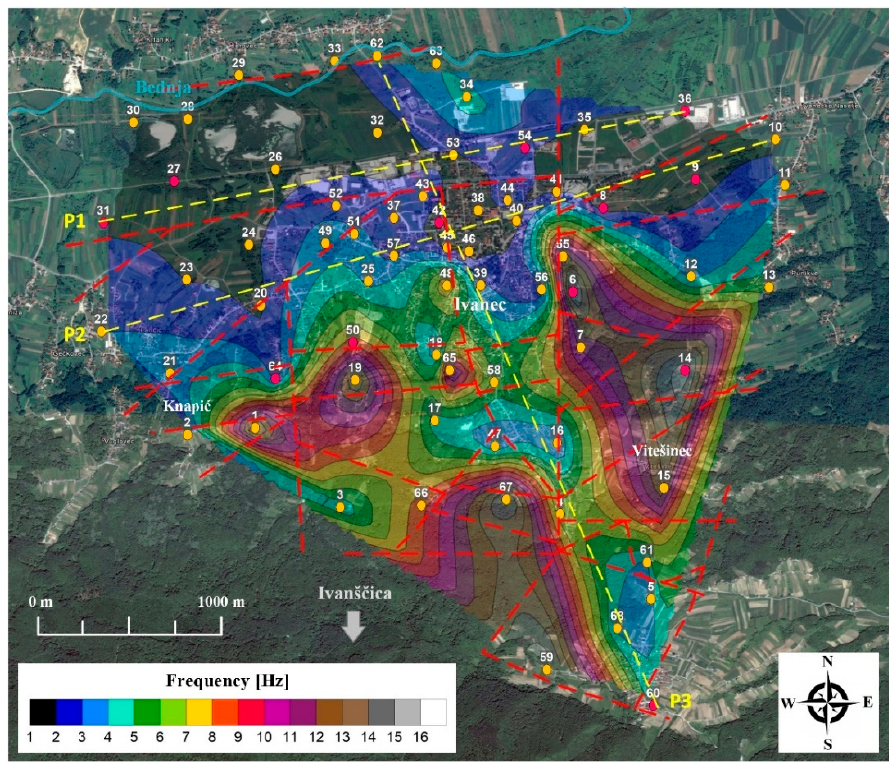
Figure 6. Map of the fundamental HVSR soil frequencies obtained for the City of Ivanec with marked faults (red dashed lines) based on geological map (Figure 3). Yellow circles indicate microtremor measurements and red geophysical measurements. Extrapolated HVSR amplitude-frequency contours vs. distance profiles marked with yellow dashed lines will be shown in Figure 10.